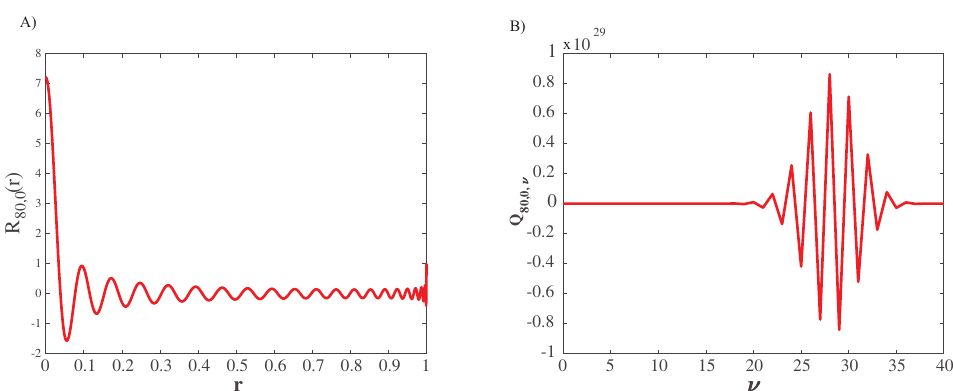
Figure 1. Instabilities in evaluating the R nl radial polynomials . In panel ( A ), we show the values of R 80,0 ( r ) as a function of r , based on a stable evaluation of the polynomial function (see text for details). In panel ( B ), we show the values of the coefficients Q 80,0, ν , the monomial expansion of R 80,0 ( r ) . The values of R 80,0 ( r ) as a function of r , based on a stable evaluation of the polynomial function vary in the interval [ − 1.57, 7.20 ] , where the largest value is reached for r = 0. Numerical application of Equation (9) wrongly indicates that R 80, l ( r ) varies in the interval [ − 4149, 4 × 10 13 ] (results not shown). This is due to the fact that the coefficients Q 80,0, ν are large (up to 10 29 ), as illustrated in panel B of Figure 1. Those